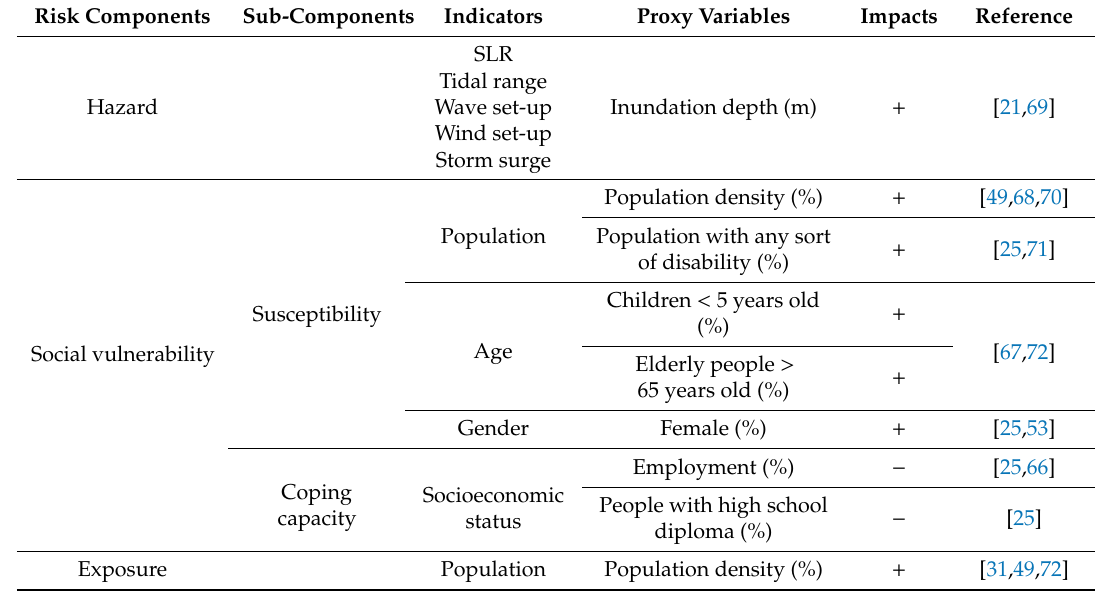
Table 2. Risk components, sub-components indicators, proxy variables and their impacts on the flooding risk